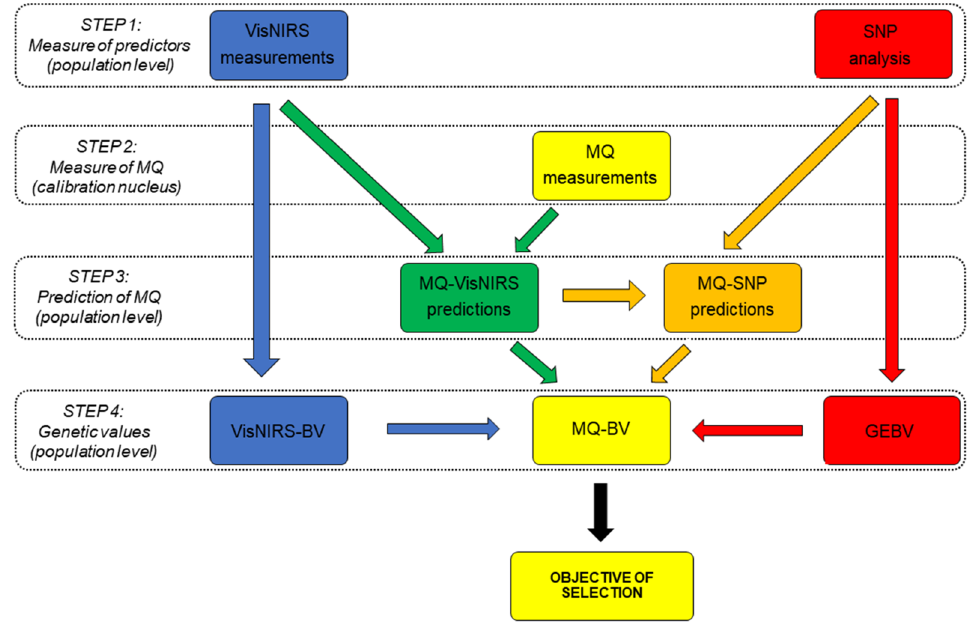
Figure 5. Schematic approaches for improvement of meat quality (MQ). Schematic approaches for improvement of MQ through: direct phenotypic selection from reference meat quality measurements at nucleus level (yellow pathway); indirect genetic selection (green pathway); direct genetic selection (blue pathway); indirect genomic selection (orange pathway) and direct genomic selection (red